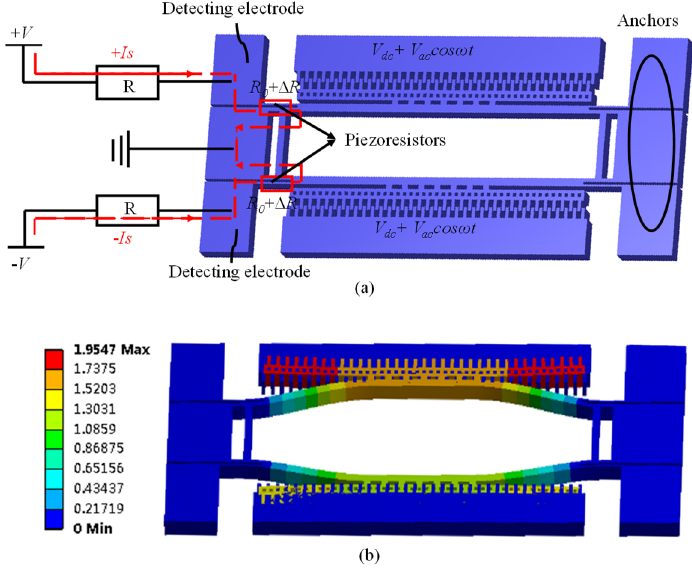
Figure 2. Setup ( a ) and simulation ( b ) of double-ended tuning forks relying on comb drive actuation and piezoresistive detection.